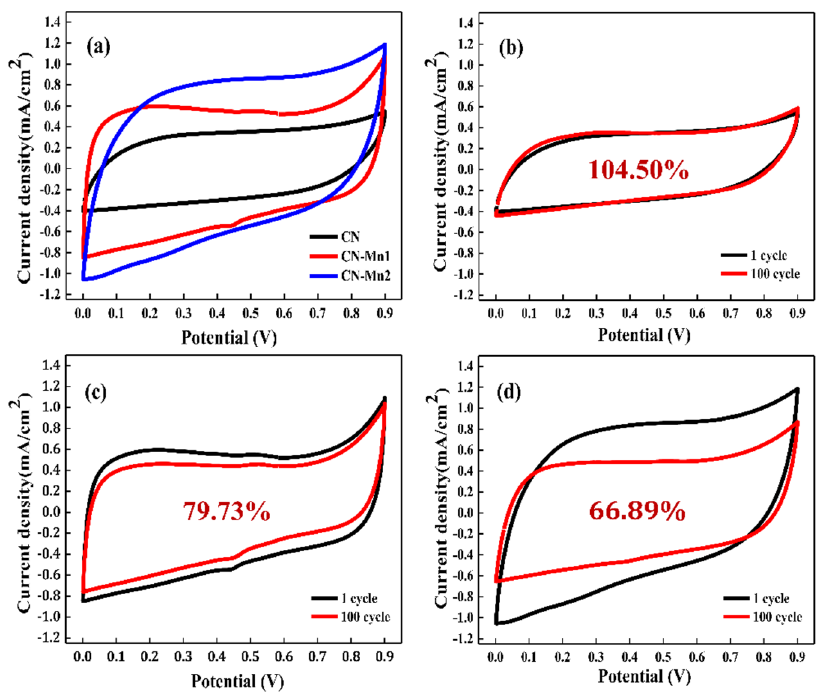
Figure 8. ( a ) Cyclic voltammograms of CN-Mn samples, cyclic voltammograms at di ff erent CV cycles of ( b ) CN, ( c ) CN-Mn1 and ( d ) CN-Mn2 with 2 mV / s scan rate in 6 M KOH aqueous solution.